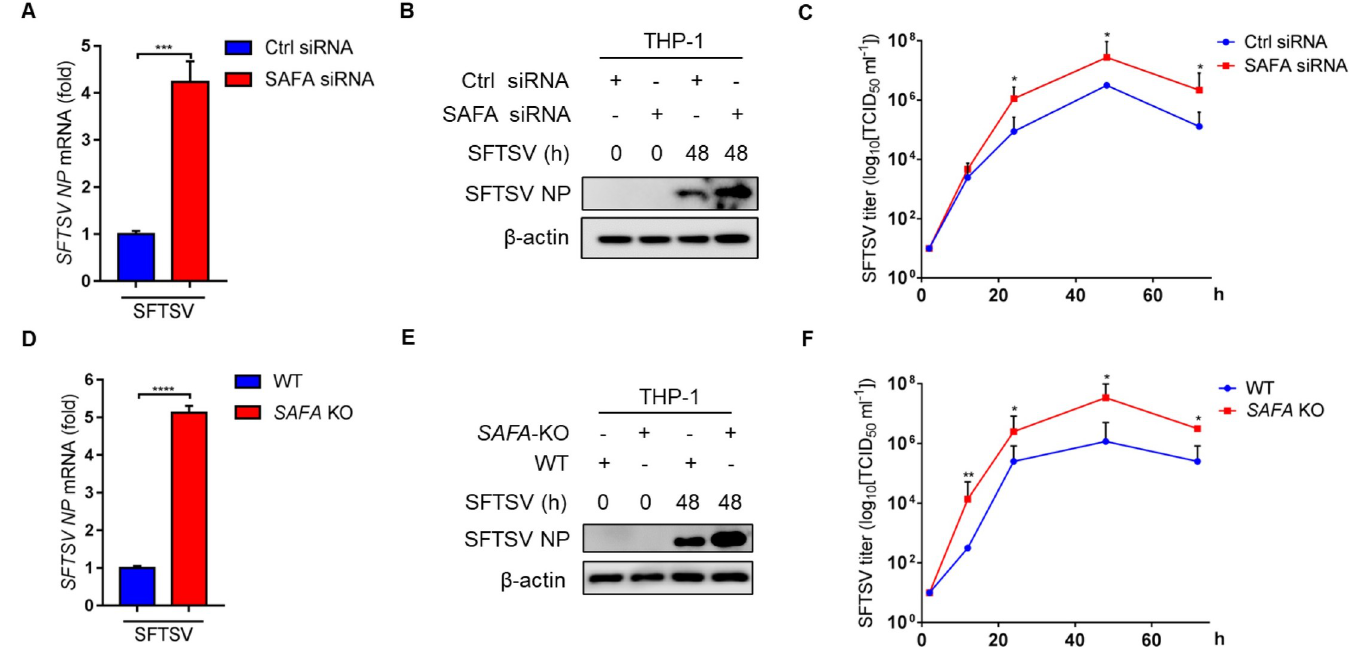
Fig 4. SAFA deficiency promotes SFTSV replication. (A-B) THP-1 cells were transfected with SAFA siRNA (10 μ M, 24 h) and control siRNA (10 μ M, 24 h), and infected with SFTSV (MOI = 10) for 48 h, mRNA (A) and protein (B) levels of SFTSV NP were analyzed by RT-PCR and Western blot. (C) THP-1 cells were transfected with SAFA siRNA (10 μ M, 24 h) and control siRNA (10 μ M, 24 h), and infected with SFTSV (MOI = 10) for indicated time. SFTSV titers were measured by TCID 50 assays. (D-E) WT and SAFA -/- THP-1 cells were infected with SFTSV (MOI = 10) for 48 h, mRNA (D) and protein (E) levels of SFTSV NP were examined by RT-PCR and Western blot. (F) WT and SAFA -/- MEF cells were infected with SFTSV for the indicated time. SFTSV titers were measured by TCID 50 assays. Data were obtained from three independent experiments (n = 3). � P < 0.05, �� P < 0.001.